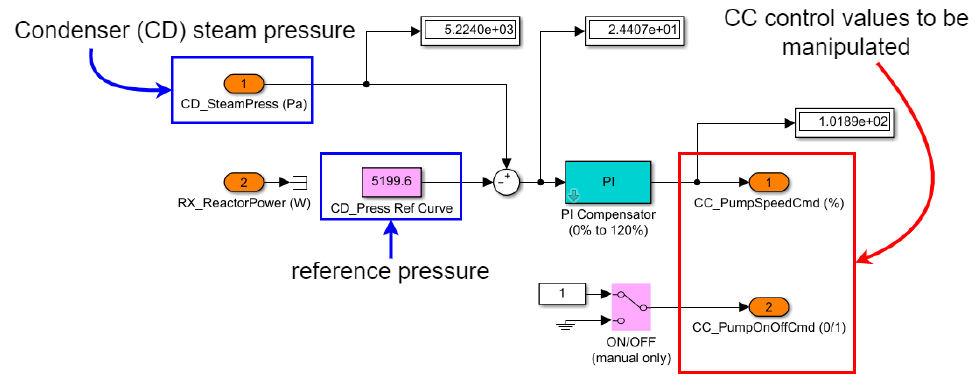
Figure 11. CD Press